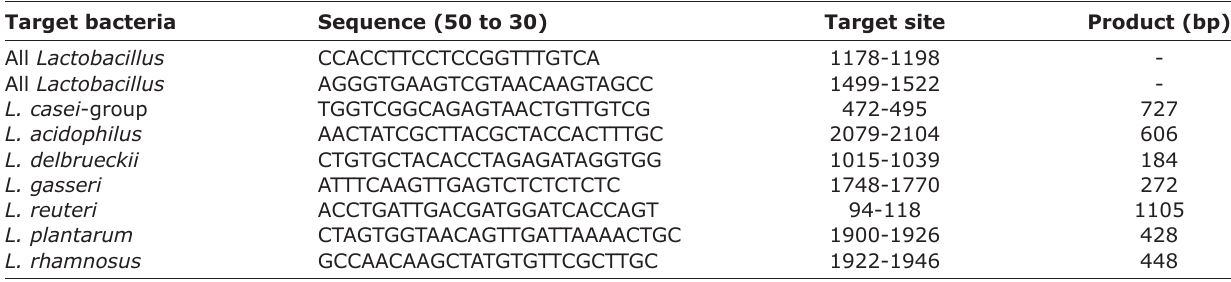
Table-1: Multiplex PCR primers that were used in the current study. Target